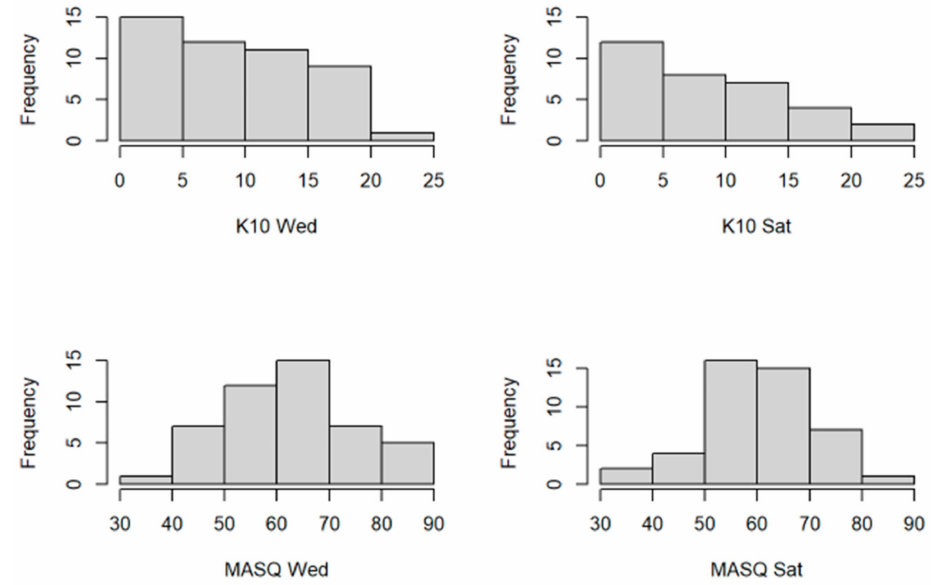
Figure 1. Histogram of the K10 and MASQ scores on Wednesday vs. Saturday, reflecting the distribution of mental well-being scores among students.